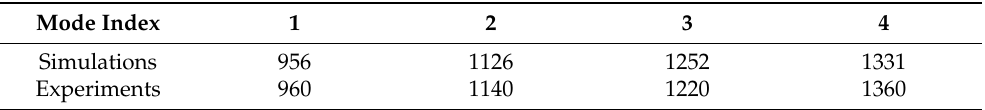
Table 1. Comparison of the natural frequencies, in Hz, obtained from acoustic simulations with resonant frequencies extracted from experimental measurements for the unified, large-aspect-ratio- cavity